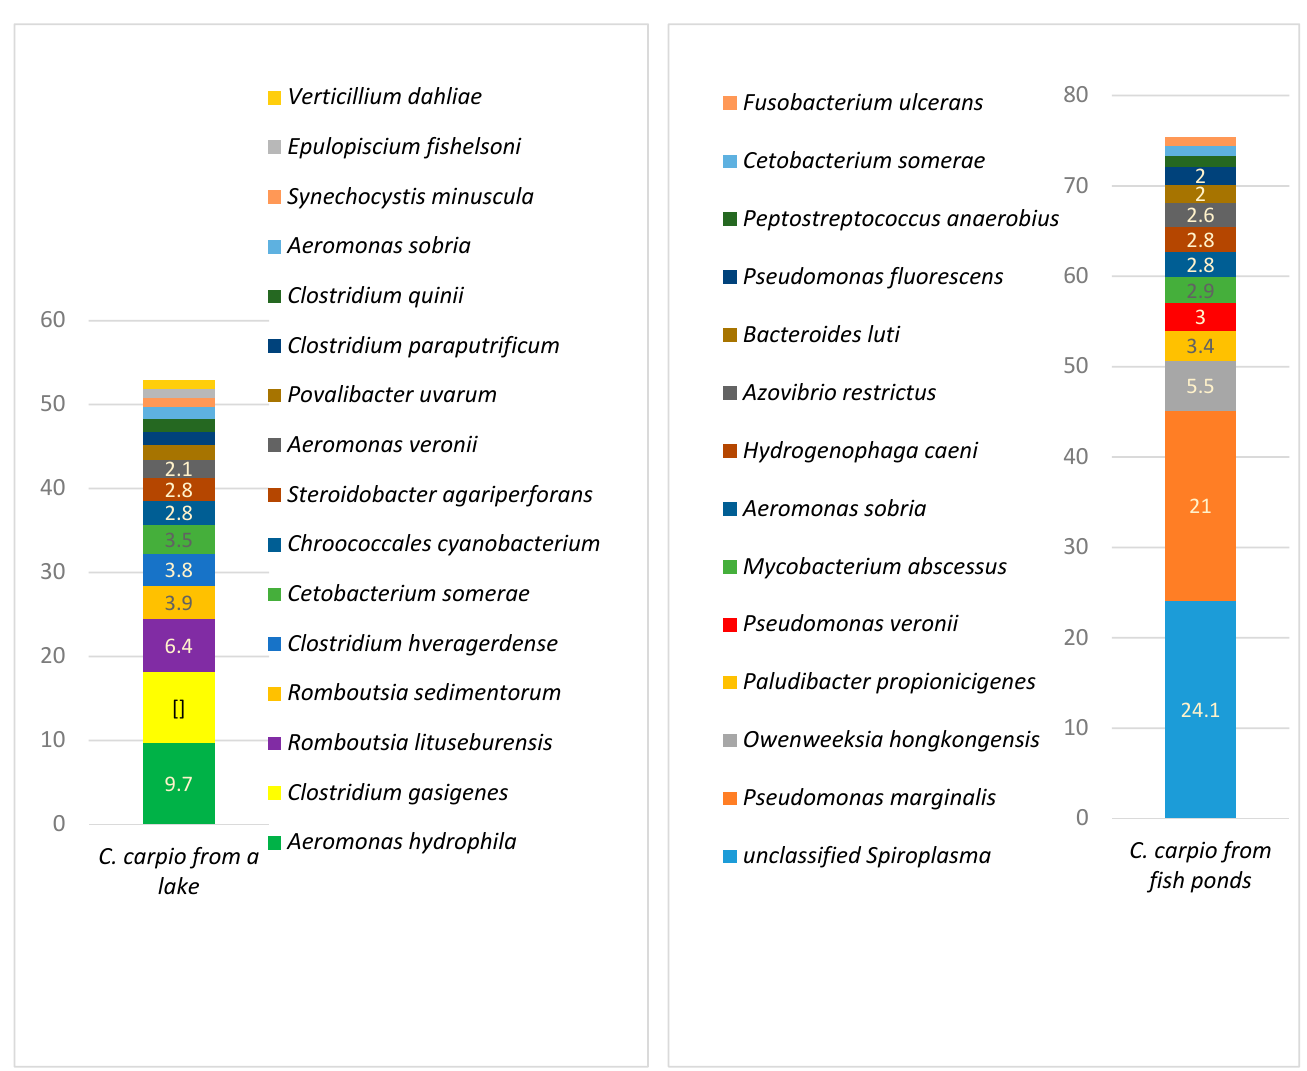
Figure 5. Bacterial species prevalence (%) in C. carpio gut (prevalence of at least ≥ 1%) .